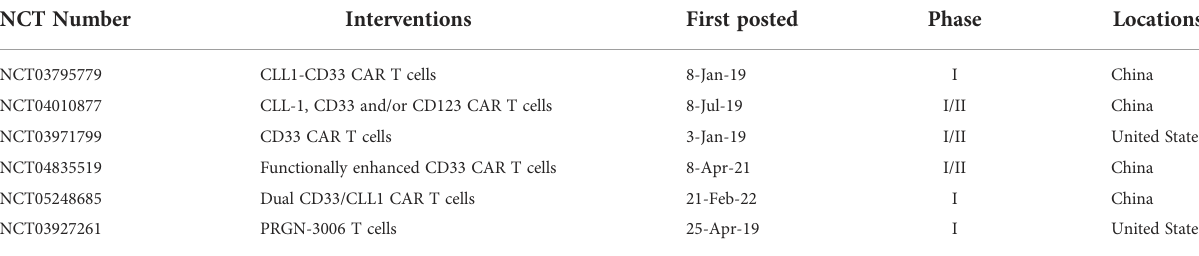
TABLE 5 Recruiting CD33 CAR clinical